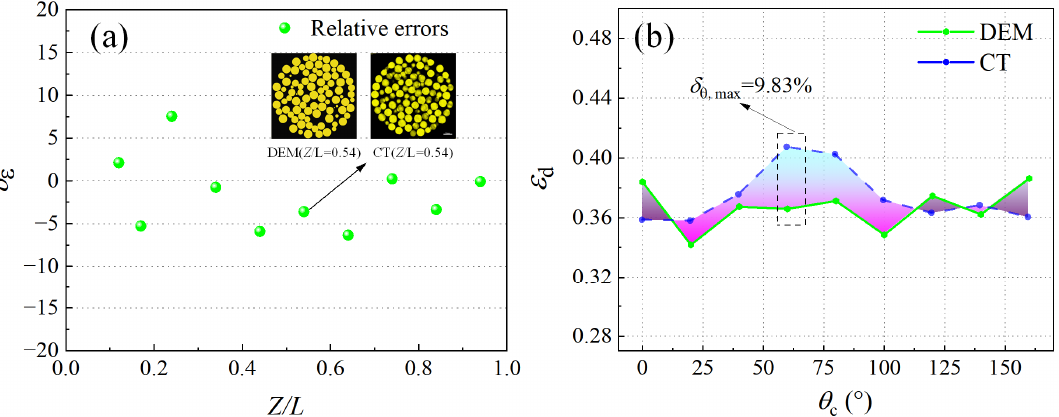
Figure 8. Comparison of porosity between the experimental data and the simulated results: ( a ) at different dimensionless heights; ( b ) at different radial sections. different dimensionless heights; ( b ) at different radial